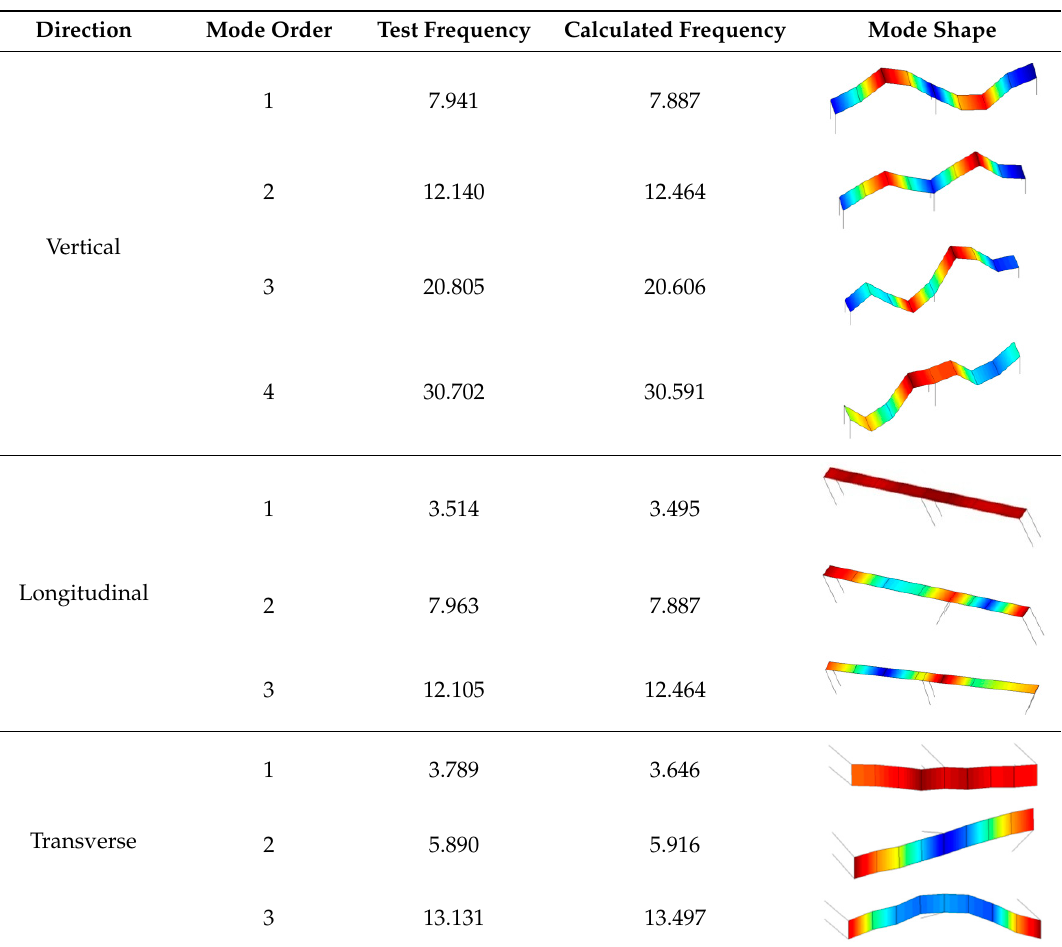
Table 3. Natural Vibration Characteristics of the Bridge Specimen with HDR Bearings.